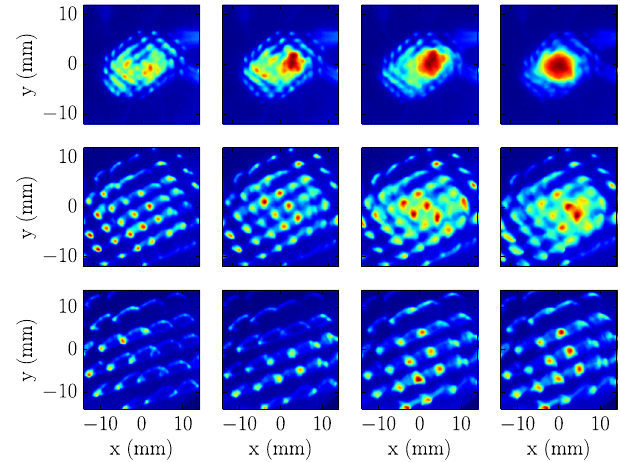
FIG. 8. False color measured 7 MeVelectron beam patterns for various matching solenoid current setting and charge. From left to right: Q ¼ 60 ,80,100,and120pC.Theimagesfromtoptobottom correspond to matching-solenoid currents of 215, 240, and 270